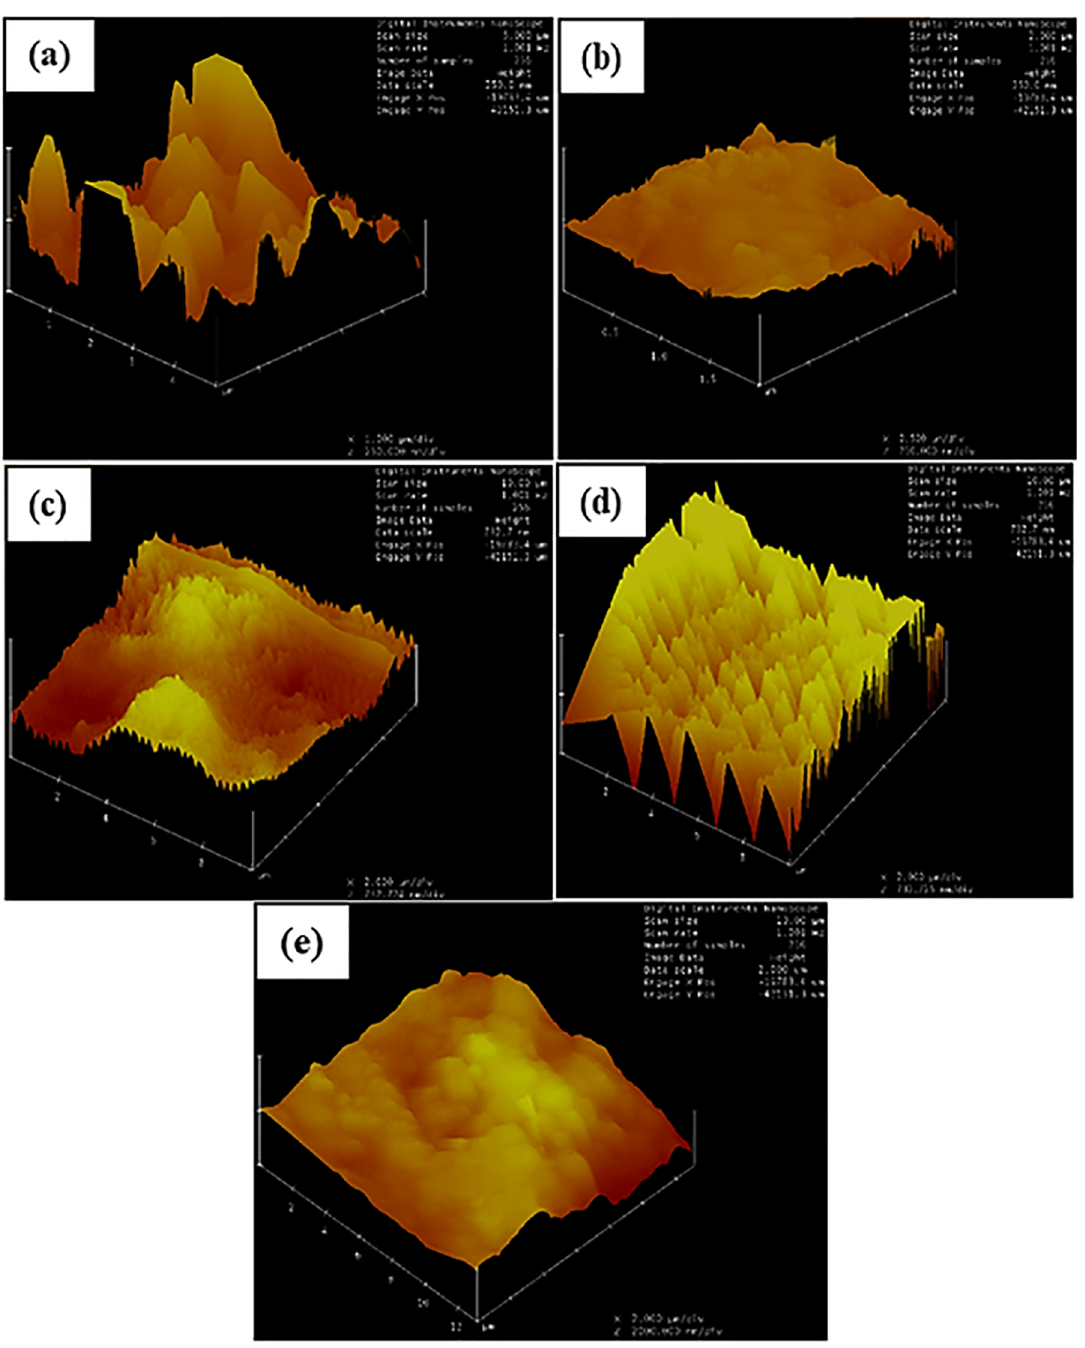
C composite (a) Sample MB1 deposited at laser power of 1600 W; (b) Sample Figure 7. AFM images of laser deposited Ti6Al4V+B 4 MB2 deposited at laser power of 1800 W (c) Sample MB3 deposited at laser power of 2000 W (d) Sample MB4 deposited at laser powers of 2200 W and (e) Sample MB5 deposited at laser power of 2400